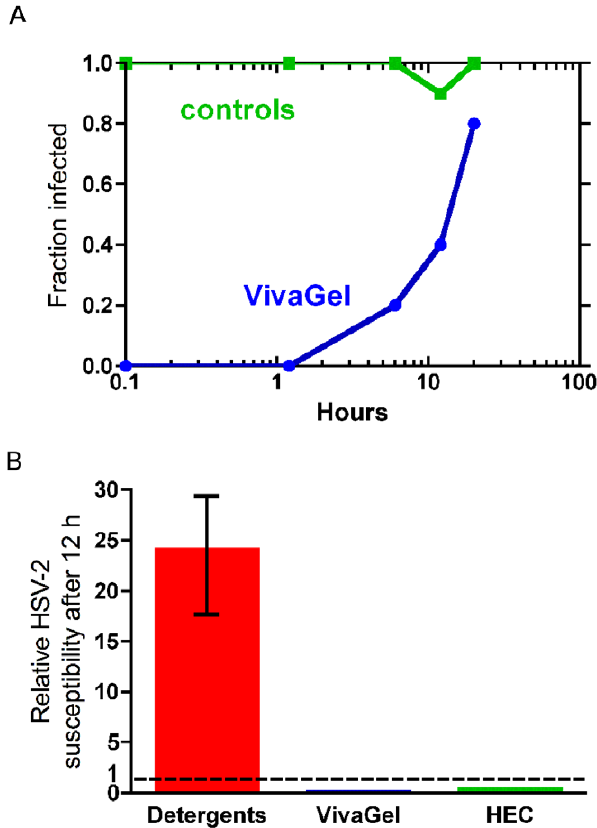
Figure 3. Formulated SPL7013, VivaGel H , protects against HSV- 2 infection and does not increase susceptibility to HSV-2 in the mouse HSV-2 vaginal transmission model. ( A ) VivaGel H provides prolonged protection against HSV-2 infection. VivaGel H (or PBS control) was delivered vaginally to groups of 10 mice and the viral challenge (10 ID 50 ) was delivered later at the times indicated. The viral inoculum infected 49 out of 50 control animals. ( B ) VivaGel H does not increase susceptibility to HSV-2. Groups of 40 mice were exposed to a single dose of VivaGel H and HEC placebo gel and after 12 h were challenged with a low dose (0.1 ID 50 ) HSV-2 inoculum. As previously reported [25], animals exposed to nonoxynol-9 and several other candidate microbi- cide detergents become more susceptible to infection for many hours after exposure reaching a peak at about 12 h after a single exposure. The increase in susceptibility, as shown by the range bar, indicates the expected increase in vaginal transmission rate for a low-dose viral inoculum. In contrast 12 h after exposure to VivaGel H fewer animals were infected than in PBS control